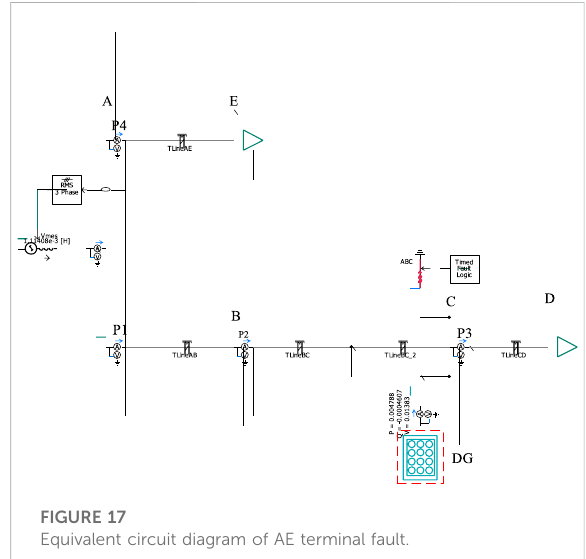
FIGURE 17 Equivalent circuit diagram of AE terminal